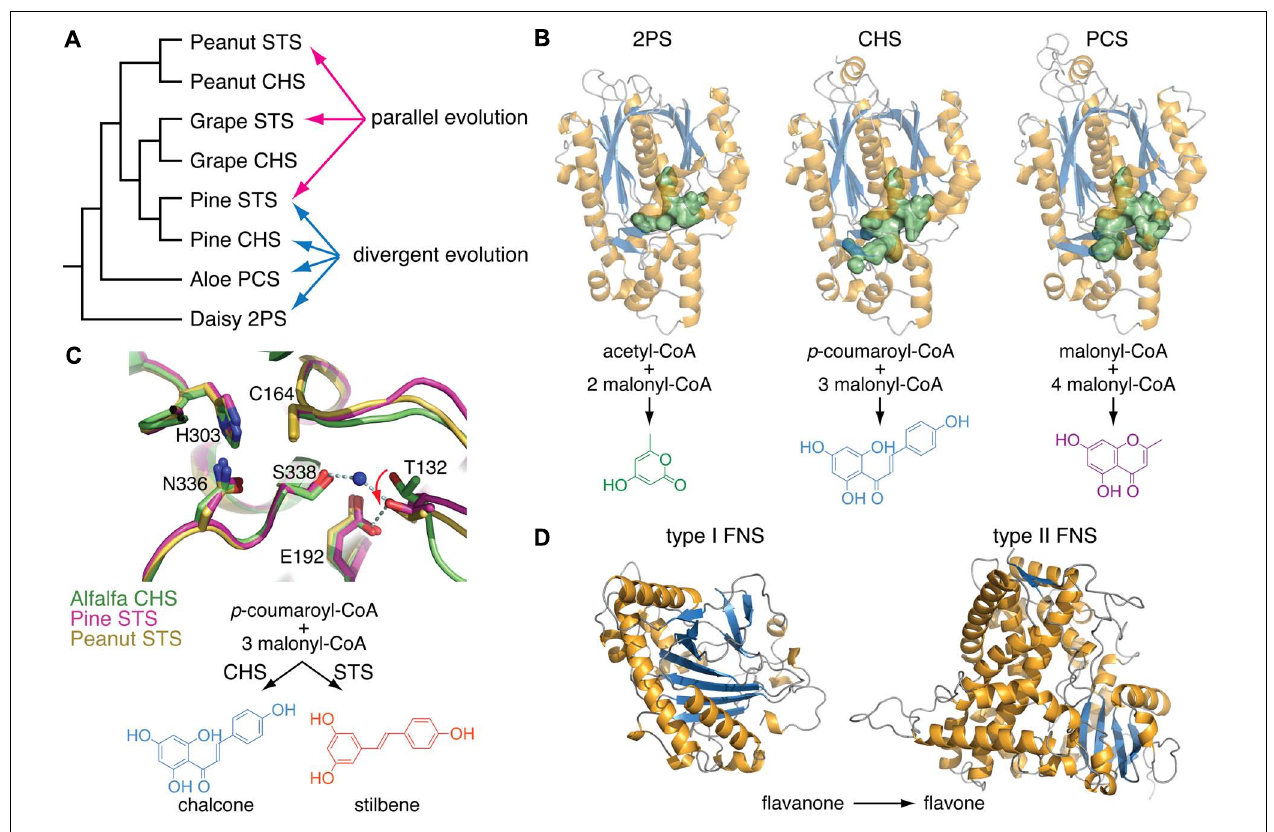
FIGURE 2 | Examples of divergent, parallel, and convergent evolution in plant specialized metabolism. (A) A cladogram showing the phylogenetic relationship of several land plant type III polyketide synthases (PKSs) involved in specialized metabolism.Whereas the expansion of enzyme families by duplication and selection over time leads to functional divergence among descendants, identical biochemical functions do arise independently from homologous ancestral forms through parallel evolution. 2PS, 2-pyrone synthase; CHS, chalcone synthase; PCS, pentaketide chromone synthase; STS, stilbene synthase. (B) Divergence of three plant type III PKSs, 2PS, CHS, and PCS. Mutational trajectories reshape the volume of the active sites (green surface representation) directly correlated with divergent biochemical functions. (C) An overlay of the active sites of CHS from alfalfa (green) and